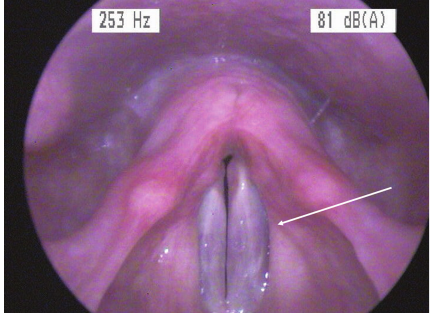
Figure 3: Edema of the left vocal cord (arrow) at 24h after surgery (sevoflurane